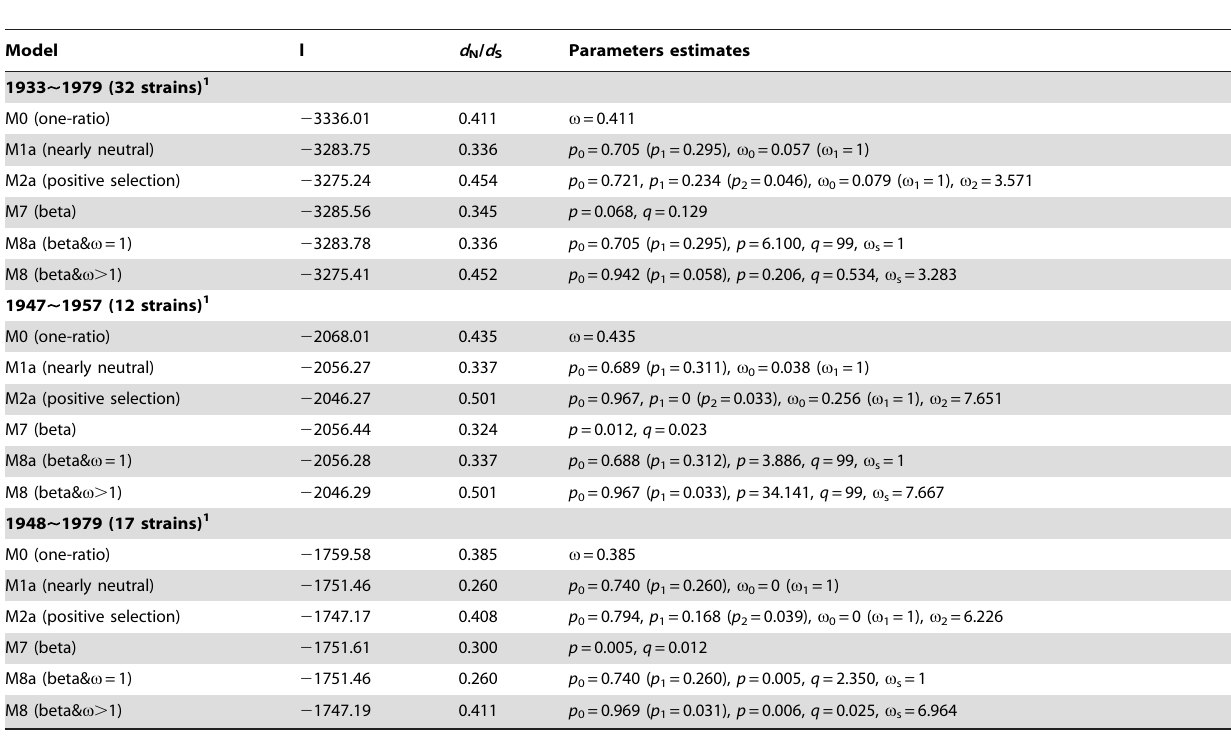
Figure 1. Antigenic structure and positive selection of A(H1N1) HA. a ) Antigenic structure of A/PR/8/34 (H1N1) HA (PDB accession code 1RU7 [78]). Five antigenic sites were identified by using a large number of monoclonal antibodies [73,74]: Sa (cyan), Sb (red), Ca1 (yellow), Ca2 (green), Cb (blue), using H3 HA numbering. The receptor-binding site (RBS) was labeled for reference. b ) Codons on A(H1N1) HA that were identified to be under various selection in PAML and HyPhy analysis. doi:10.1371/journal.pone.0007789.g001 Table 4. The values of log-likelihood (l), d N / d S , and parameter estimates in CODEML analysis of egg-adapted human A(H1N1) HAs between